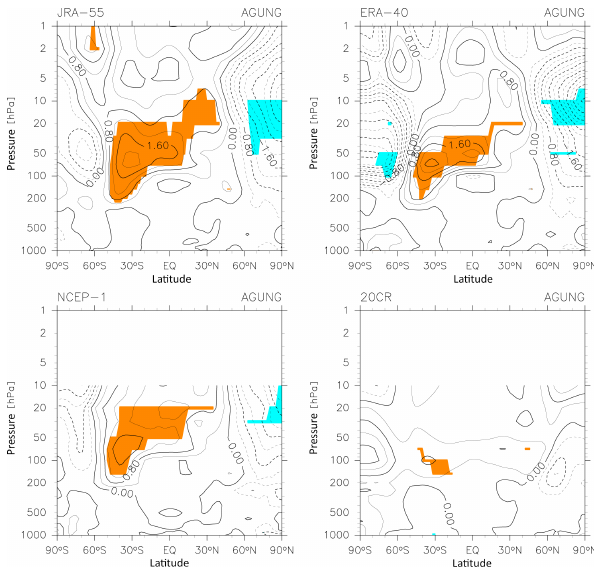
Figure 8. As in Fig. 4 but for the Mount Agung eruption in March 1963 for the 1958–2001 analysis from four reanalysis data